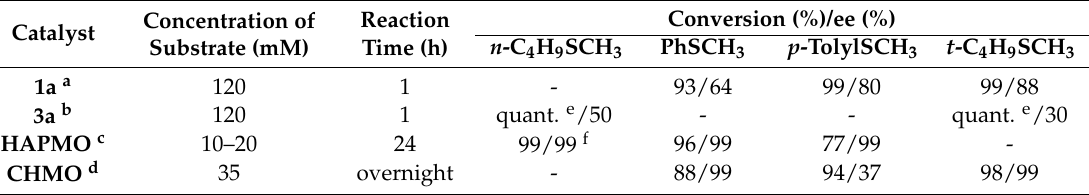
Table 3. Comparison of the catalytic activity of flavin-cyclodextrin conjugates 1a and 3a with enzymes in sulfoxidations of selected